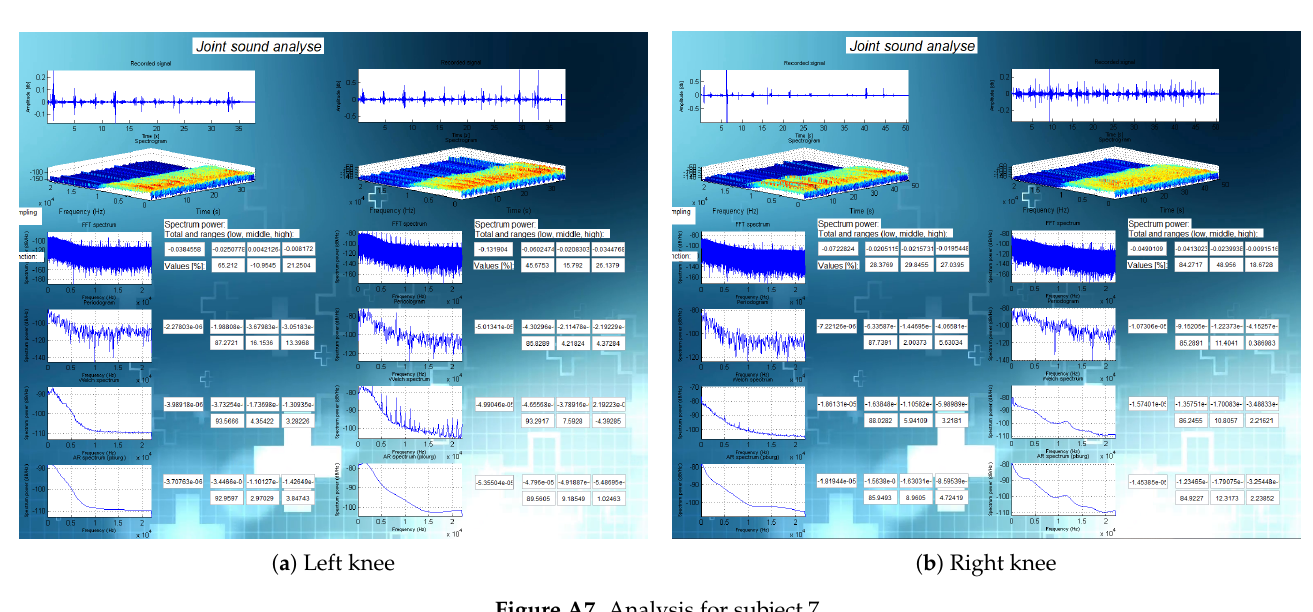
Figure A7. Analysis for subject 7. 8. standing, physical condition: Average, knee injuries: Right knee injury related to skiing, other remarks: Swimming, irregularly; spinal disc herniation at L2–L3 level (Figure